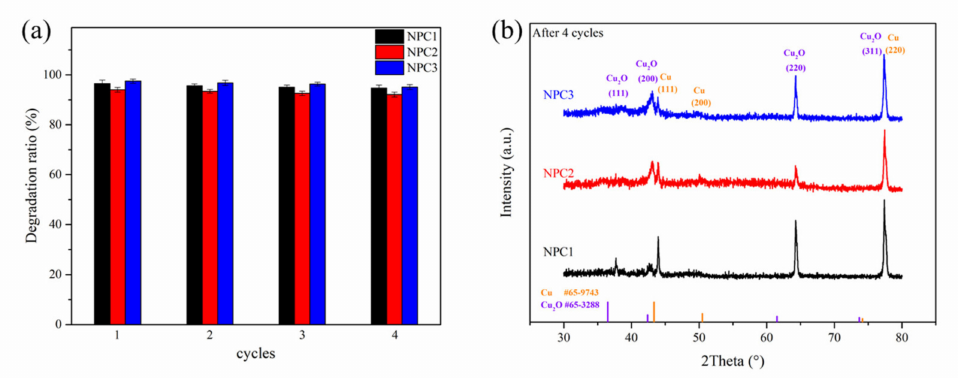
Figure 6. Cycle runs for the MO degradation by the NPC1, NPC2, and NPC3 catalysts under sunlight ( a ); XRD patterns of NPC1, NPC2, and NPC3 catalysts after four cycles ( b